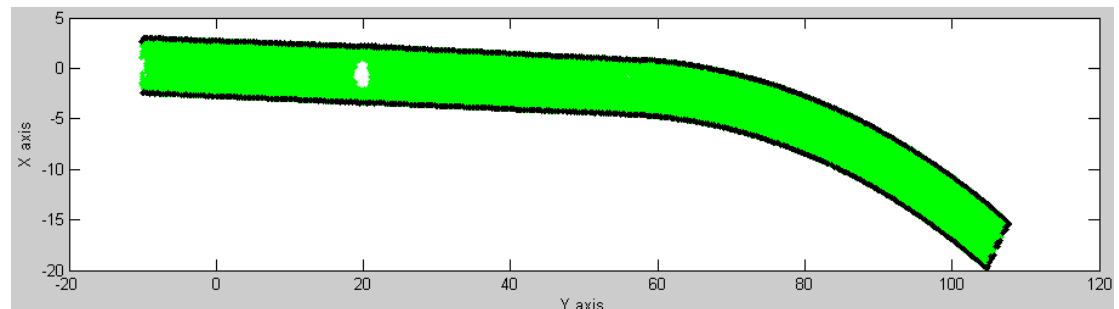
Figure 9. 2D projection of the tunnel points onto the XOY plane.